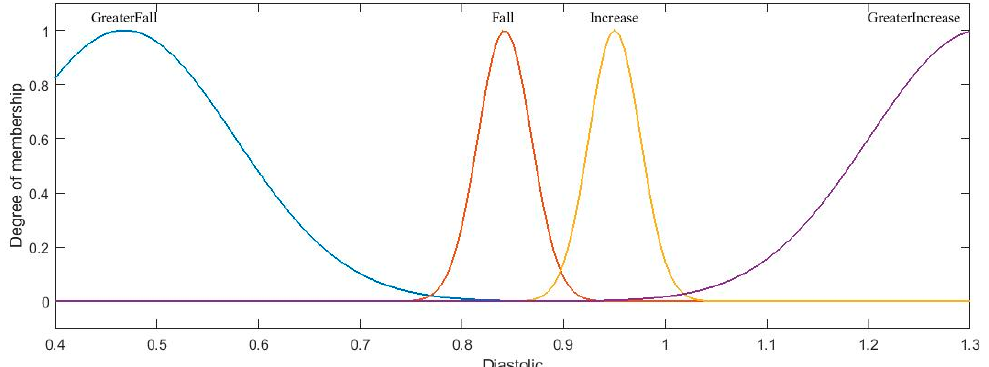
Figure 21. Optimized systolic quotient input.